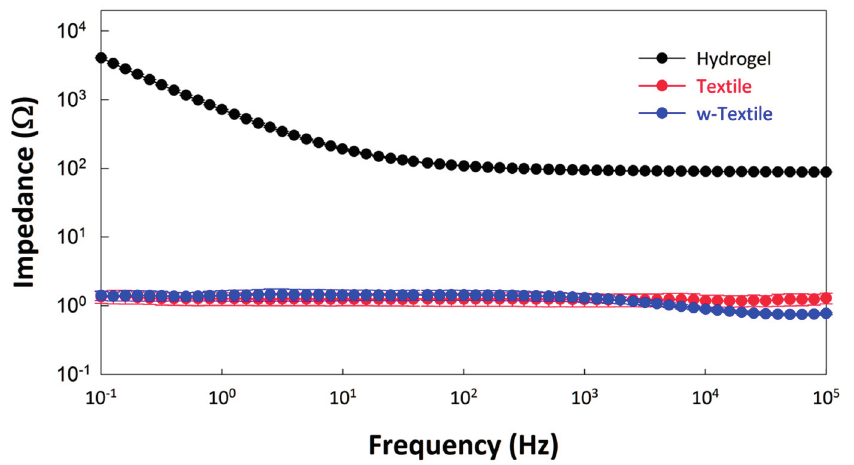
Figure 7. Impedance of the hydrogel electrode, textile electrode, and wet textile electrode tested on large-area stainless steel